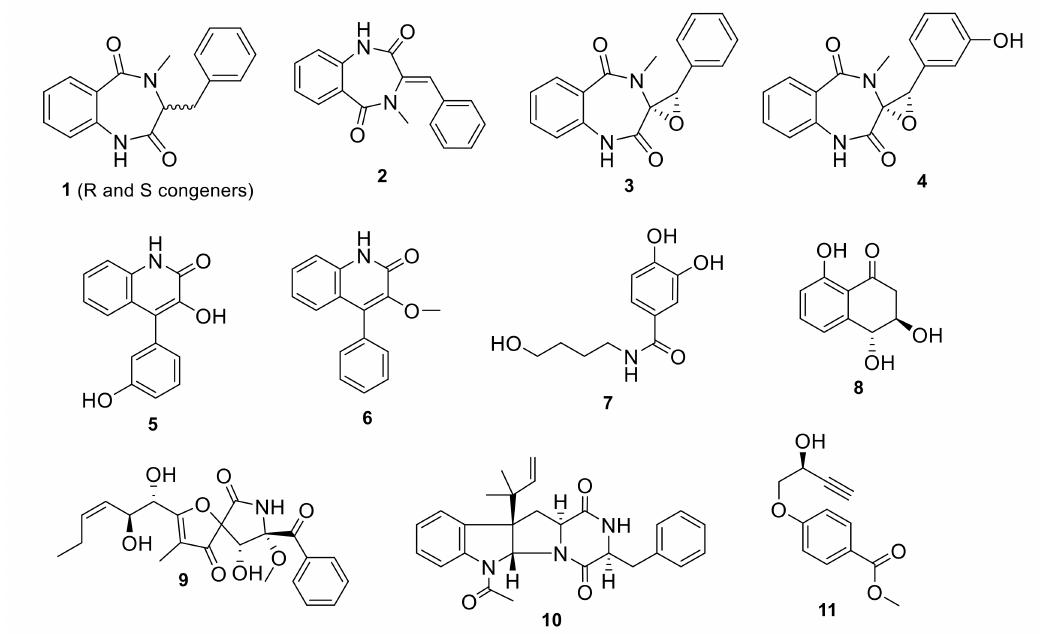
Figure 1. Compounds isolated from the endophyte Penicillium citrinum